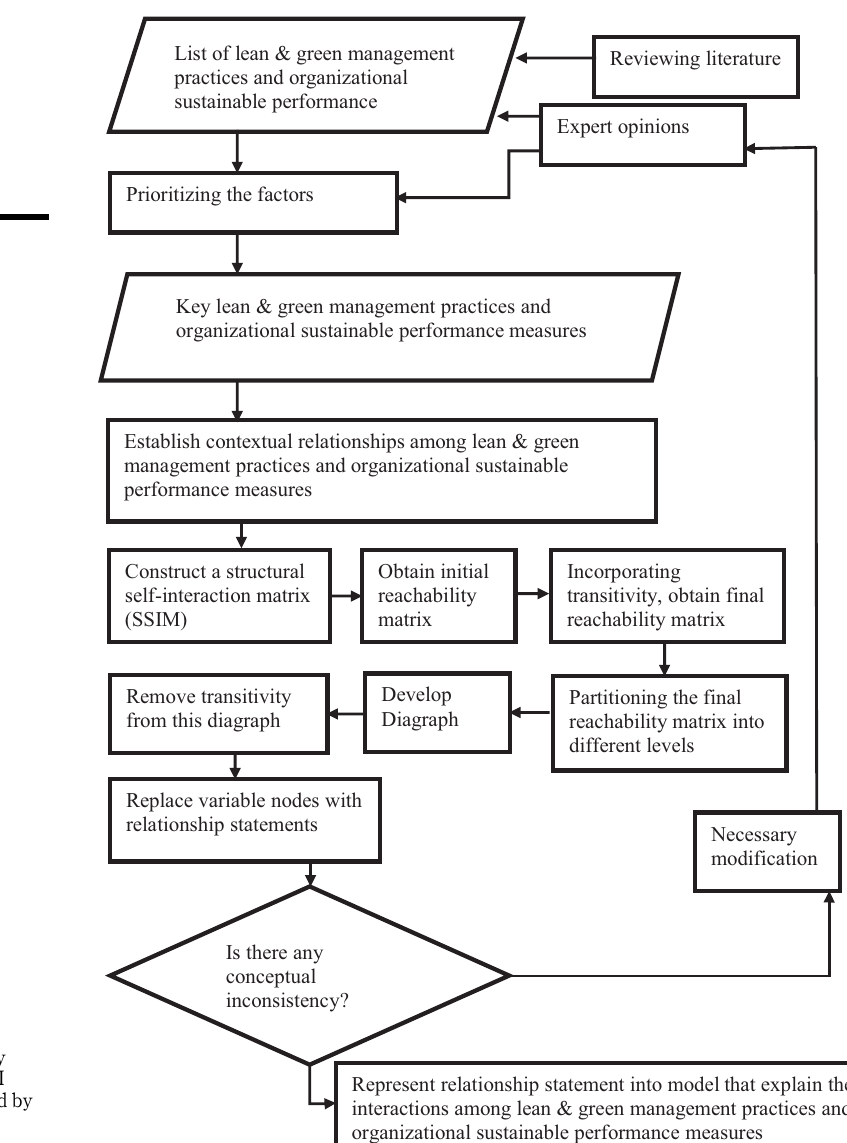
also were selected purposively, concerning their expertise. As Figure 1 (flow of the study), demonstrates, a Structural Self-InteractionMatrix(SSIM)(seeMatrix1 intheresults) was used to document the experts ’ opinions on the interactions among the key lean, green management practices and organizational sustainable performance measures. Afterward, based on the relationships emphasized in the SSIM, the Initial Reachability Matrix (IRM) was developed.